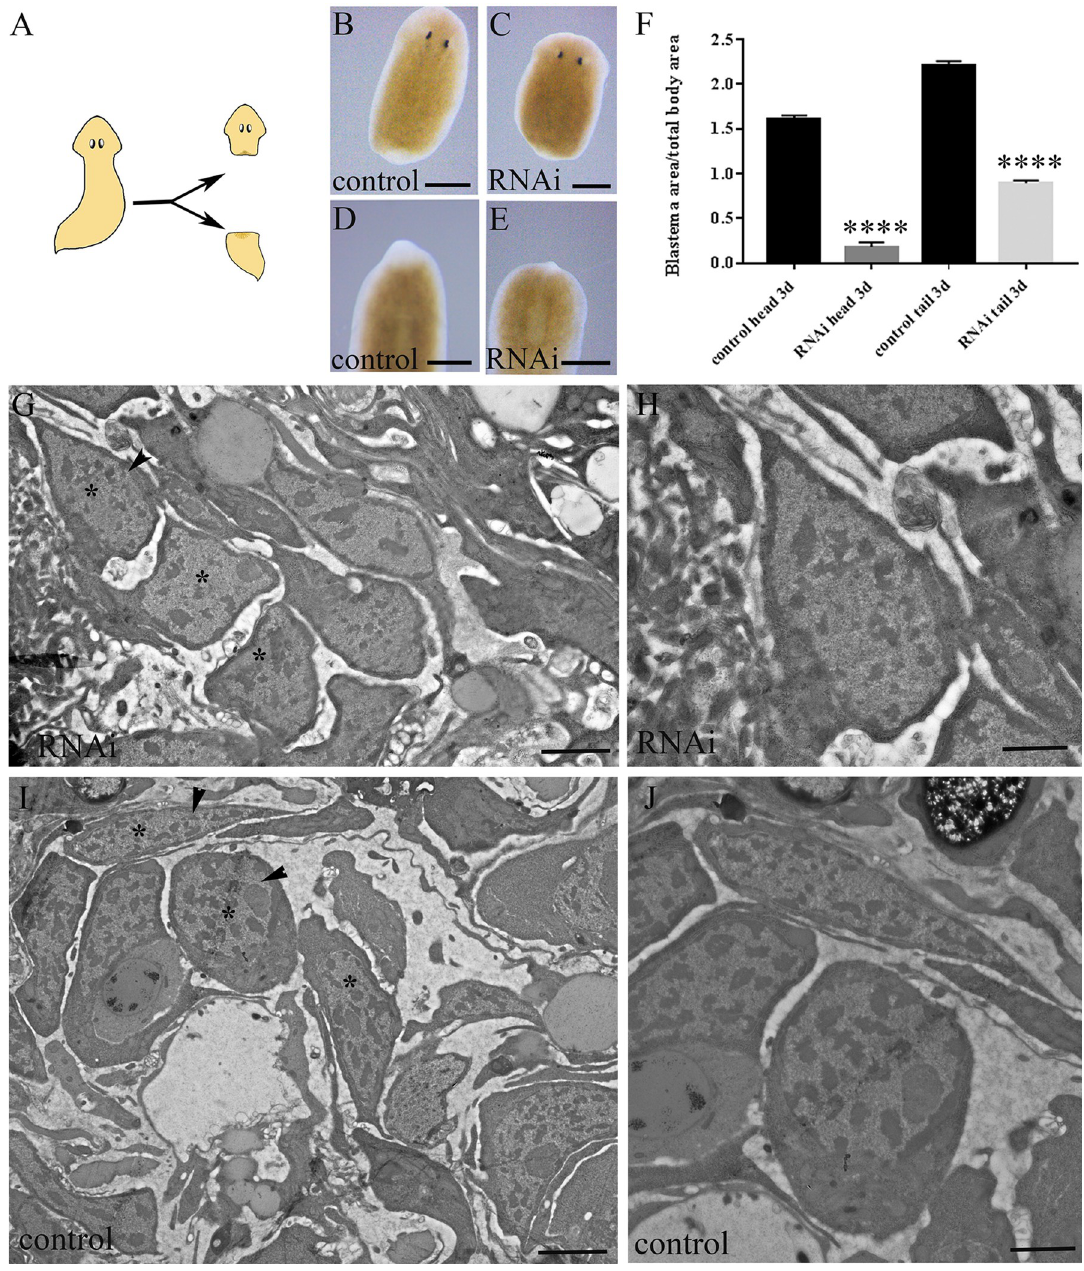
Fig 2. Analysis of regenerating blastema in DjMap1B -silenced animals. (A) Schematic drawing of the amputation level producing a head fragment and a tail fragment. (B) A representative head fragment of a control animal and (C) RNAi animal 3 days after amputation. (D) Representative tail fragment of a control animal and (E) RNAi animal 3 days after amputation. (B-E) are dorsal view. (F) Graph depicting the quantification of blastema size. Each bar is the mean ± standard deviation of 15 independent samples of a representative experiment. ���� p < 0.0001. (G) Representative electron micrograph of the regenerating area of a DjMap1B- silenced (RNAi) animal and (I) a control 3 days after amputation showing some neoblasts (asterisks). (H, J) Magnification of the cells indicated by the black arrowheads in G and I showing morphological features of neoblasts. d (days). Scale bar is 500 μ m in A-D, 2 μ m in G and I, and 800 nm in H and